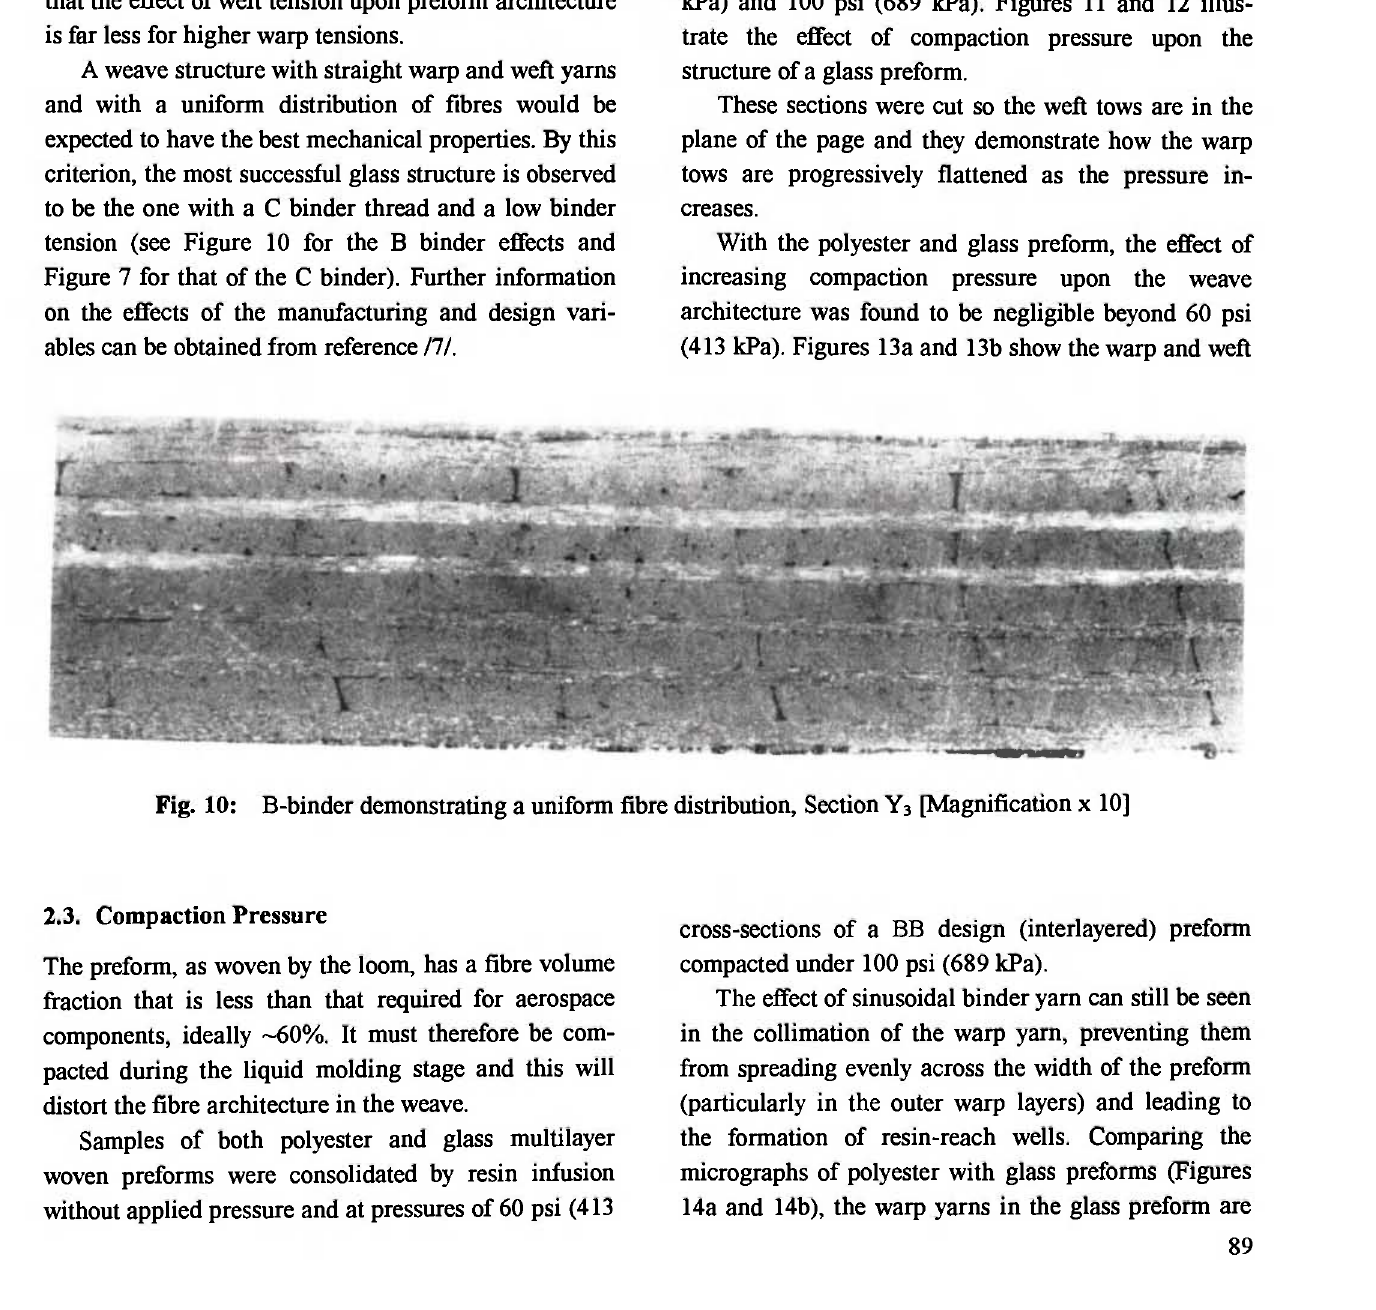
(low weft tension) [Magnification χ 10] 3